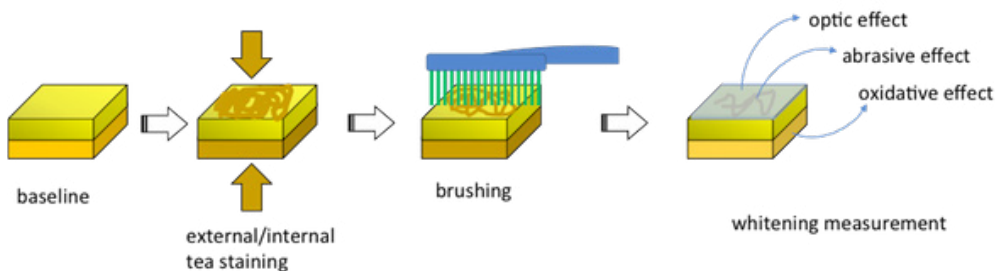
Figure 2- Staining protocol of the sample and possible whitening effects of the different whitening toothpastes tested, as a function of their whitening technology